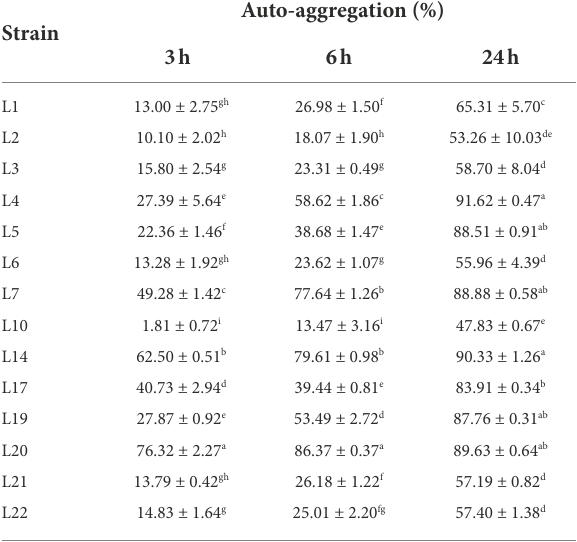
TABLE 4 Auto-aggregation abilities of potential probiotic LABs from cow milk. 1